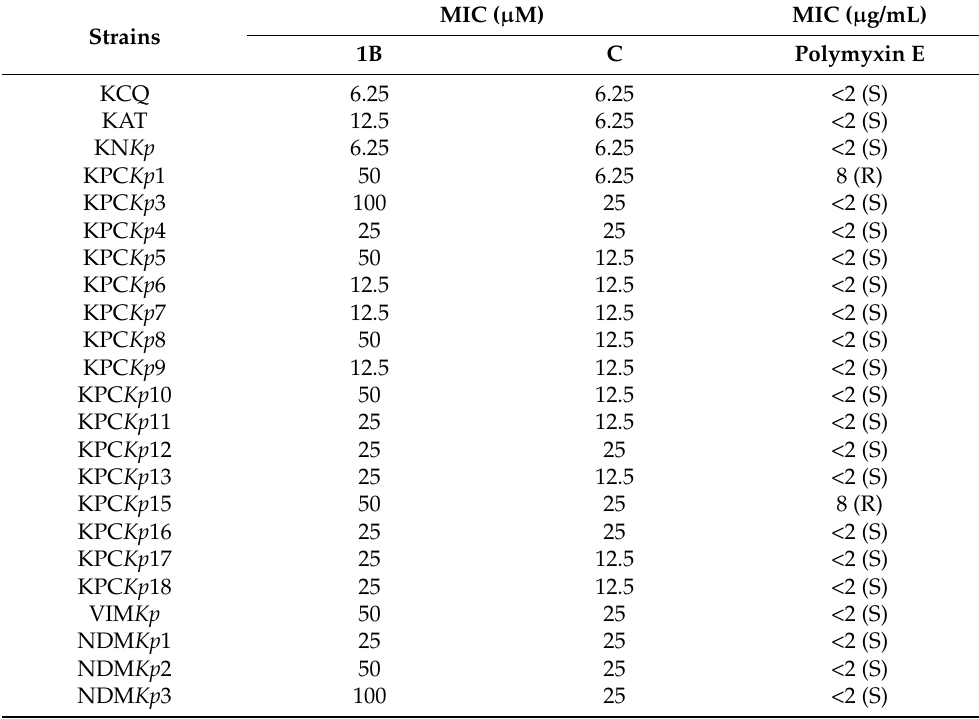
Table 3. Minimum inhibitory concentrations (MIC) of peptides 1B and C against K. pneumoniae test